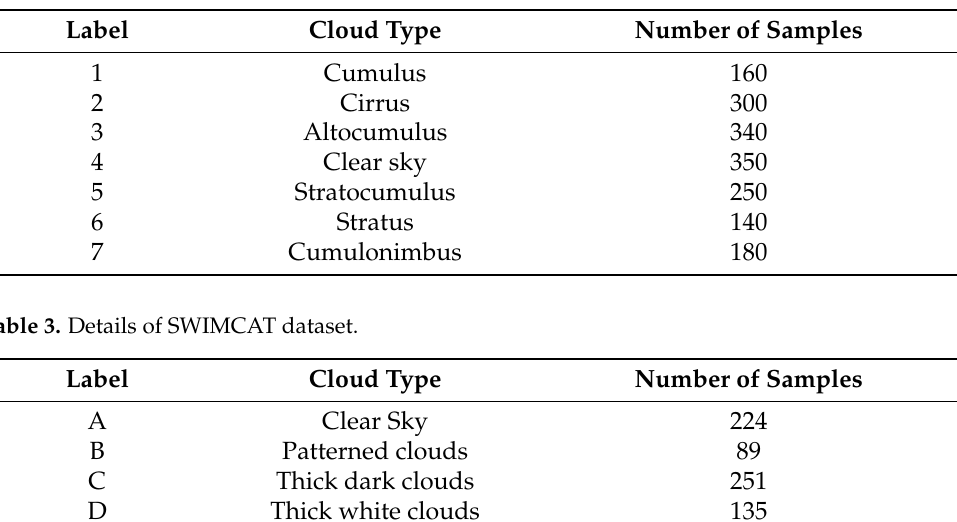
Table 2. Details of MGCD dataset.